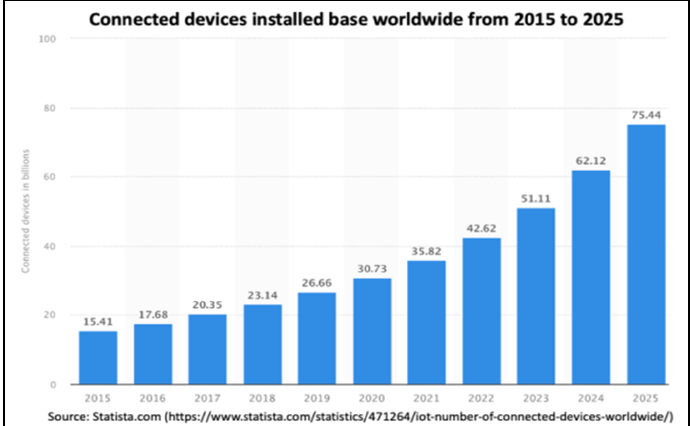
Figure 1. The exponential growth of connected devices (Statista.com) .